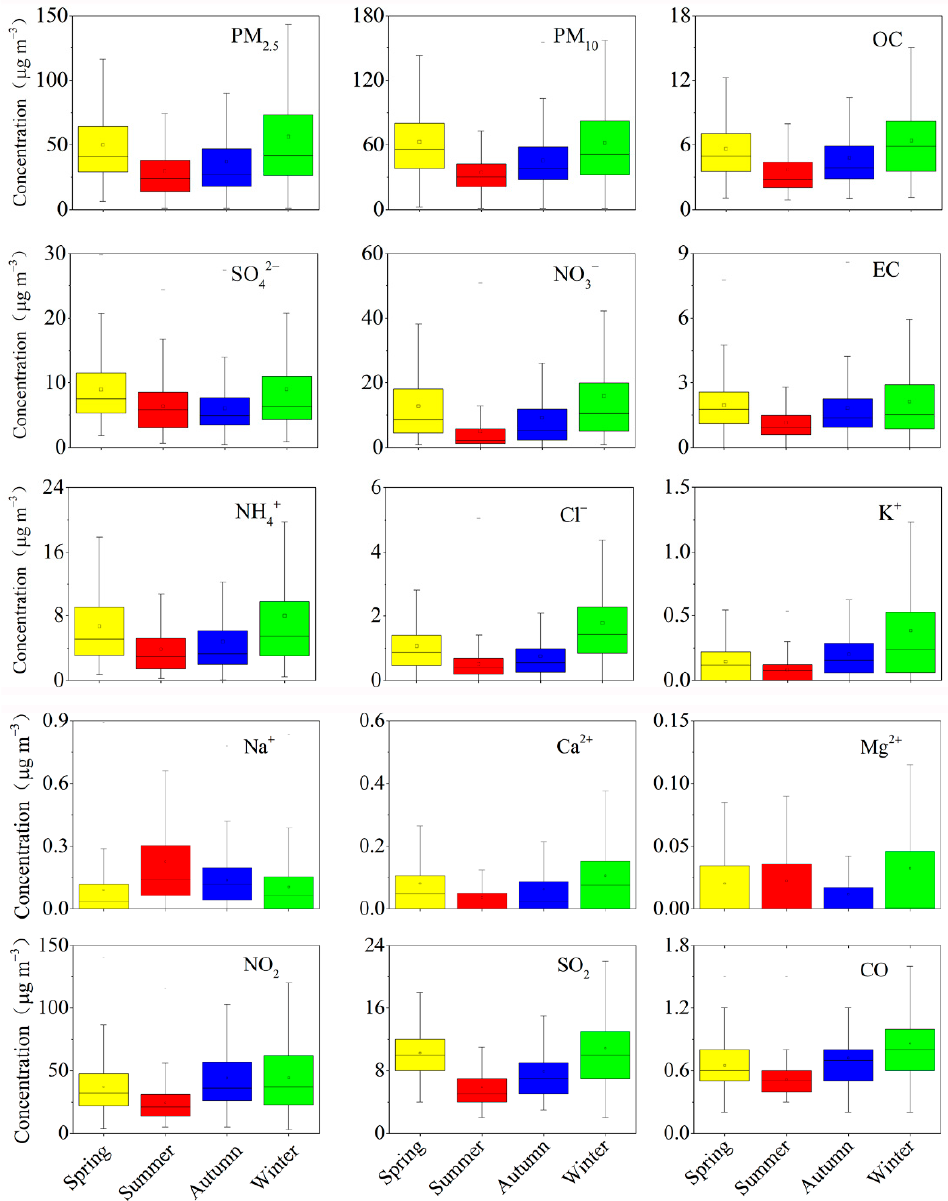
Figure 2. Seasonal distributions of chemical PM 2.5 components and gas pollutants. Note that the middle horizontal line, small rectangle, up-line, and the down-line of each histogram denotes the median, average, 25% quantile, and 75% quantile, respectively. The short lines, located above and below each histogram, represent the maximum and minimum values, respectively.